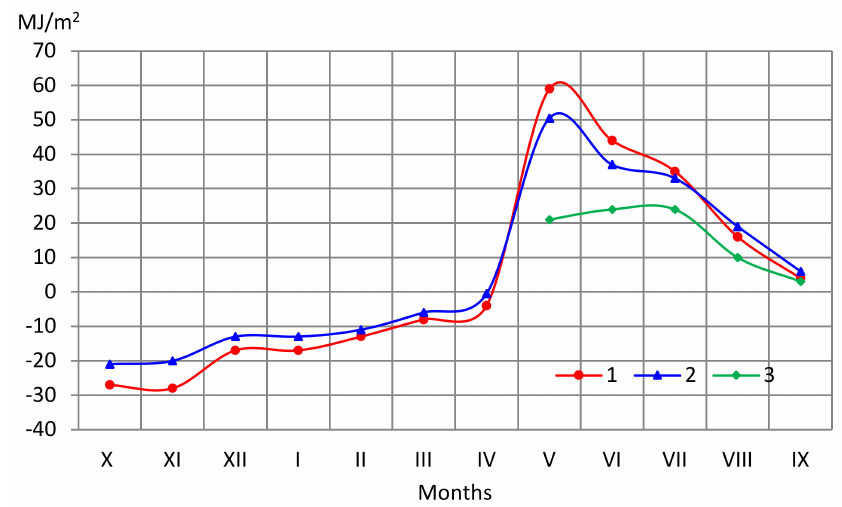
Figure 4. Annual course of ground heat flux at the riparian location (1), creek valley bottom (2) and lower slope (3), from